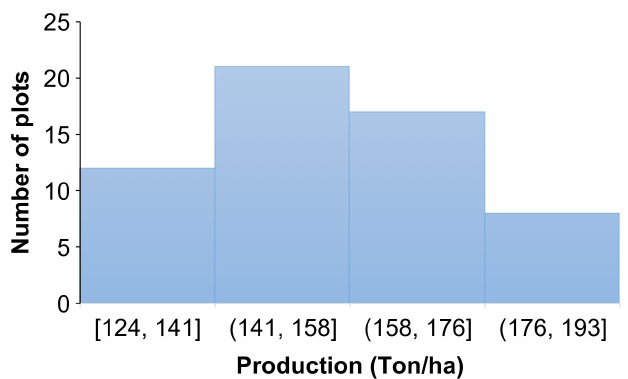
Figure 8. The tomato production histogram for the 58 parcels used in the training and validation of the production model based on